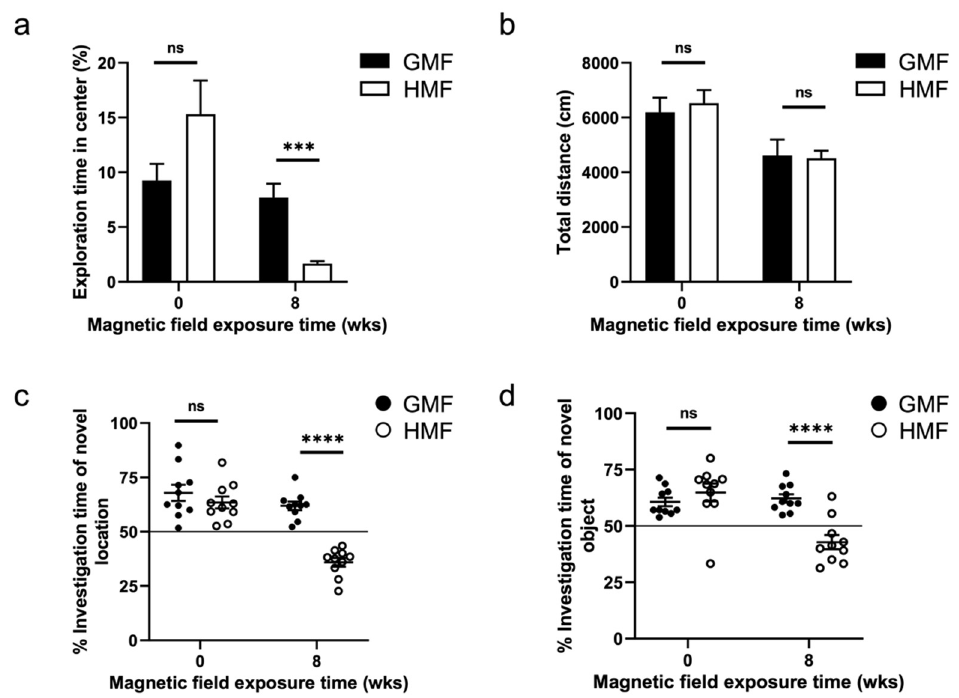
Figure 1. Results of Open-Field, OLT, and NOR tests in GMF- and HMF- exposed mice ( n = 10/group). ( a ) The percent time spent in the center of the open field in mice at 0 w and 8 w GMF/HMF exposure. *** p = 0.0002, unpaired t -test. ( b ). The total traveled distances in the open field test in mice at 0 w and 8 w GMF/HMF exposure. ( c ) The percentage of time spent exploring the novel location in mice at 0 w and 8 w GMF/HMF exposure. **** p < 0.0001, unpaired t -test. ( d ) The percentage of time spent exploring a novel object in mice at 0 w and 8 w GMF/HMF exposure. **** p < 0.0001, unpaired t -test. Data are presented as mean ± SEM. n.s. = not